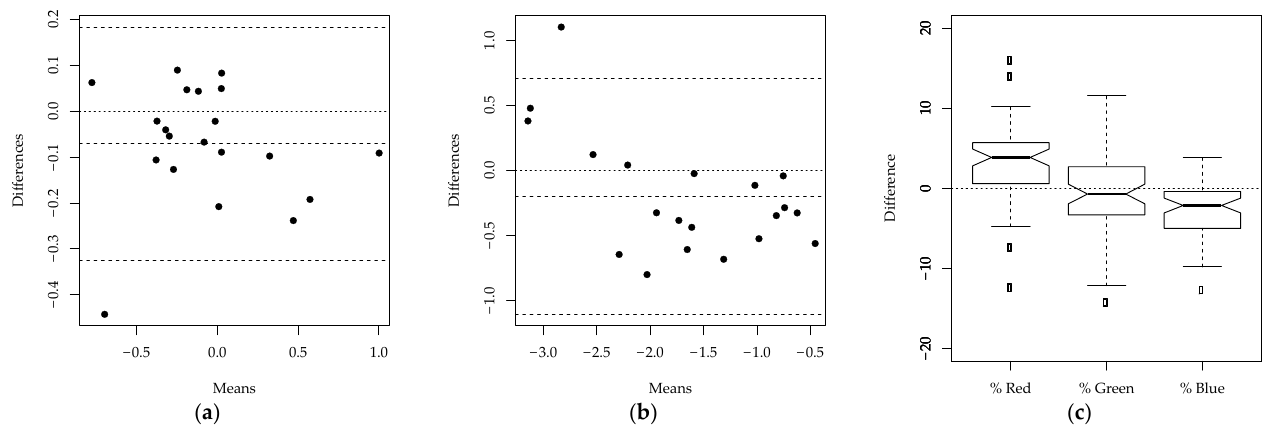
Figure 6. Agreement between manual method and ImageJ: ( a ) Bland-Altman plot—First dimension of ILR-transformed data; ( b ) Bland-Altman plot—Second dimension of ILR-transformed data; ( c ) Boxplots of the differences between the measurements obtained using manual method and ImageJ, for each color